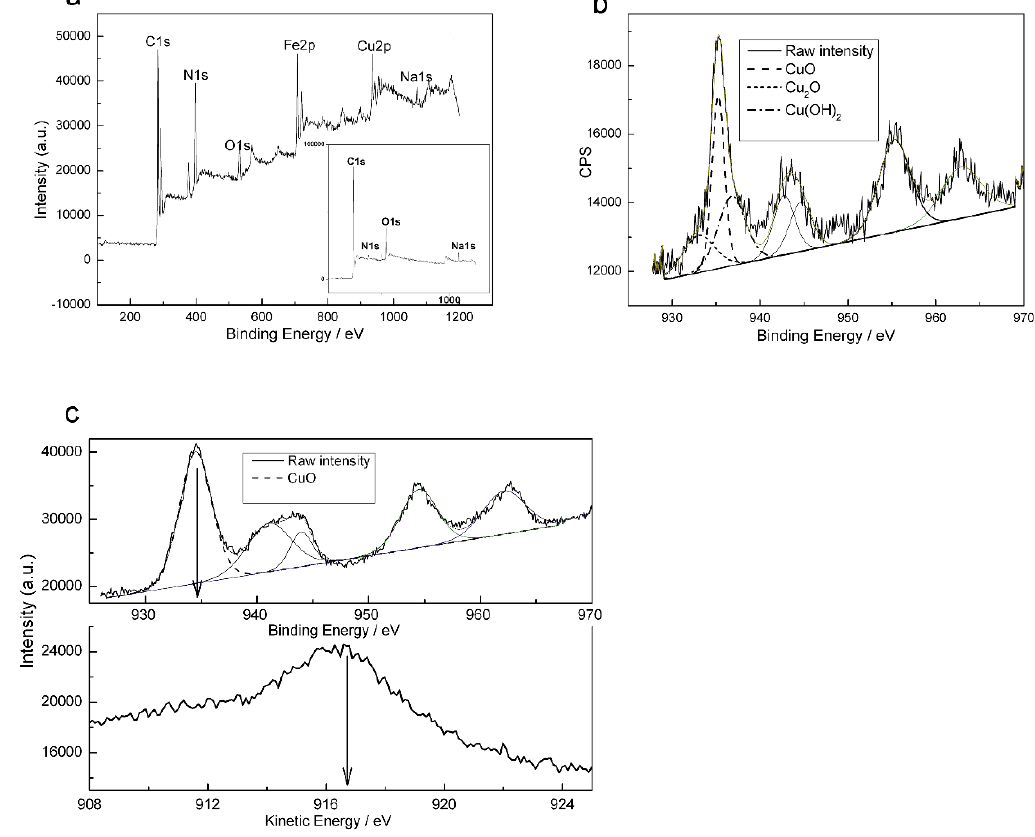
Figure 2. X-ray photoelectron spectroscopy (XPS) spectra of the cathode materials. ( a ) Wide-scan XPS survey spectra of the modified carbon cloth after being applied as cathode in the microbial fuel cell (MFC) for a period of time. Inset: bare carbon cloth. ( b ) Cu 2p core-level. ( c ) The XPS spectrum of the unused copper-coated carbon cloth; the upper and lower part were the spectra of Cu 2p and Cu LMM (L-inner level-M-inner level-M-inner level electron transition), respectively. This material had been dried at room temperature for 24 h.